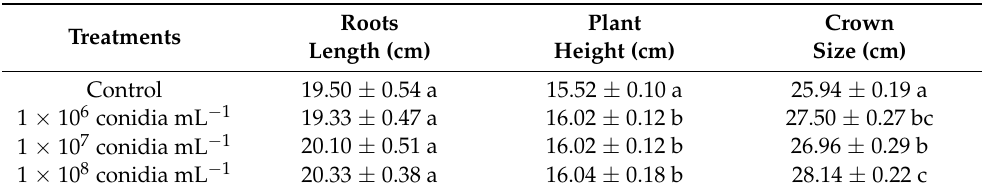
Table 2. The effect of Beauveria bassiana on root length, plant height and crown size of the plants ( Lactuca sativa ) at varying conidial concentrations ( n = 200). Table 3. The effect of Beauveria bassiana on dry and fresh weights of aerial part and roots of plants ( Lactuca sativa ) exposed to different conidial concentrations ( n =